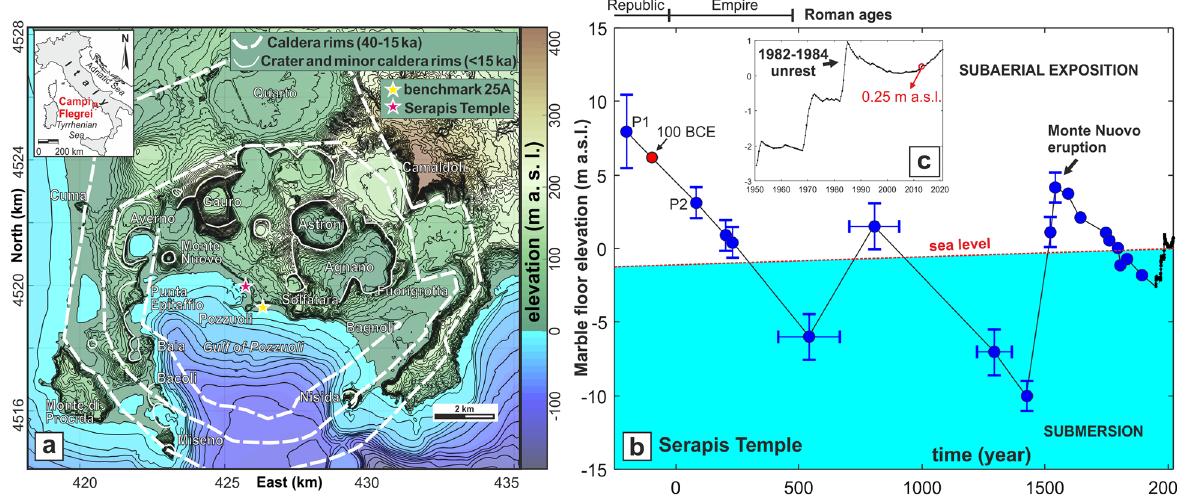
Fig. 1 a DEM of the Campi Flegrei caldera showing the main crater and caldera rims. b Vertical displacement of the Serapis Temple marble floor in the last 2200 yr (data from Morhange et al. 1999; Bellucci et al. 2006). The sea-level change curve of the Campania sector is also shown (data from Lambeck et al. 2011). c Vertical displacement of the Serapis Temple marble floor (Pozzuoli) compared to the 1950 baseline until 2021 (modified after Del Gaudio et al.